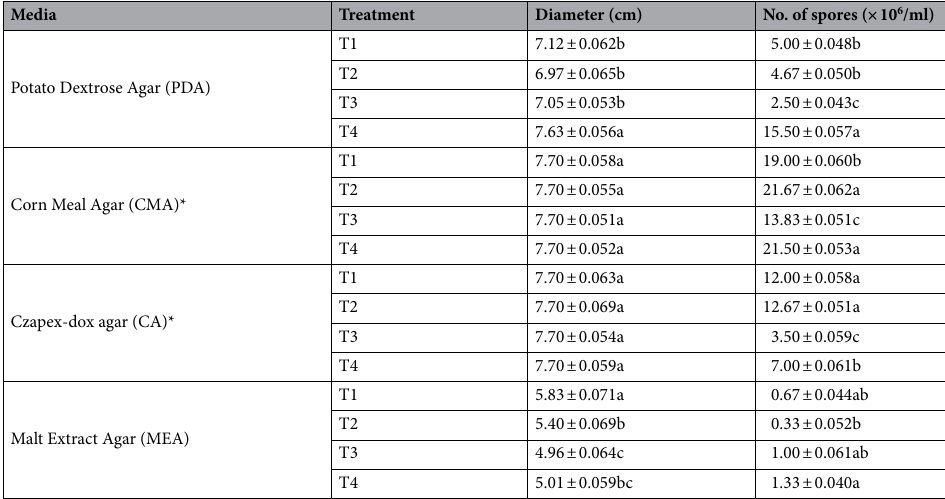
Table 3. Effect of growth medium and light cycle on Exserohilum rostratum mycelium diameter and sporulation activity. *Plates subjected to sporulation activity determination. All values are expressed as average mean ± standard deviation of three independent experiments. Treatments are denoted as following: T1; 12 h fluorescent light + 12 h black light, T2; 12 h fluorescent light + 12 h complete darkness, T3; 12 h black light + 12 h complete darkness , and T4; 24 h darkness. *Means in column with different letter are significantly different at p ≤ 0.05 level according to Fisher’s least significant difference (LSD).